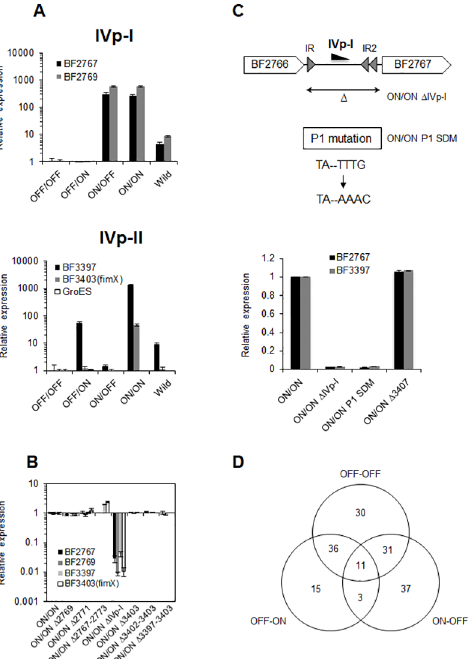
Fig 4. Orientation-specific unique transcriptional regulation by invertible IVp-I/IVp-II. (A) The expression of EPS biosynthesis genes (represented as BF2767 and BF2769) and a gene cluster (represented as BF3397 and BF3403) were dependent on IVp-I and IVp-II, respectively. The transcriptional level of the IVp-II-regulated gene cluster in the hypervesiculating mutant (ON/ON) was increased 25- to 40-fold over that of the OFF/ON mutant. (B) IVp-I was required for the full expression of the gene cluster downstream of IVp-II. A variety of deletions were generated within the EPS production locus or at the IVp-II- regulated gene cluster in the hypervesiculating mutant (ON/ON). Only the deletion of the IVp-I-containing invertible DNA region affected the expression of IVp-II-regulated genes. (C) The effects of IVp-I activity and IVp-I-related IRs on IVp-II activity. IVp-I activity was attenuated after replacing the -7 sequence (TAnnTTTG is the Bacteroides consensus promoter sequence at -7) with an inactive form (TAnnAAC) by using site-directed mutagenesis. Two IRs were present between IVp-I and BF2767 in the ON/ON mutant obtained in this study. These IRs and the entire invertible fragment containing IVp-I were deleted to examine the role of these elements in IVp-II activity. (D) Venn diagram comparing differentially expressed genes in B . fragilis mutants with different IVp-I/IVp-II orientations. The number of differentially expressed genes ( > 4-fold change) in each genotype was compared with the ON/ON genotype. The expression levels of 11 genes were specifically elevated in the ON/ON mutant (S2